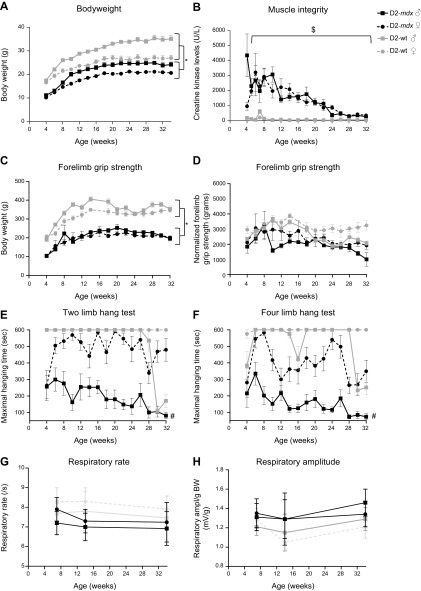
A gender and age comparison for D2-mdx and D2-WT mice shows that muscle function is severely affected in D2-mdx males, but not females, and deteriorates with age. A) D2-mdx mice were lighter than wild types. B) CK levels were elevated in young D2-mdx mice and dropped with age. C, D) Forelimb grip strength (C) was impaired in D2-mdx mice, but when normalized to body weight (D), this difference lost its significance. E, F) Performance in the 2 limb hanging test (E) and 4 limb hanging test (F) was severely impaired in D2-mdx males but not in females. G) Respiratory rate was decreased in D2-mdx mice, although this did not reach significance. H) Respiratory amplitude normalized to body weight showed a nonsignificant increase in D2-mdx mice. For G and H, significance was reached when data of both genders were pooled; n = 10 D2-mdx mice and n = 6 D2-WT mice of both genders. Values represent means ± sem. $Significant difference compared with all other groups; significant drop with age in D2-mdx mice; *P < 0.05.